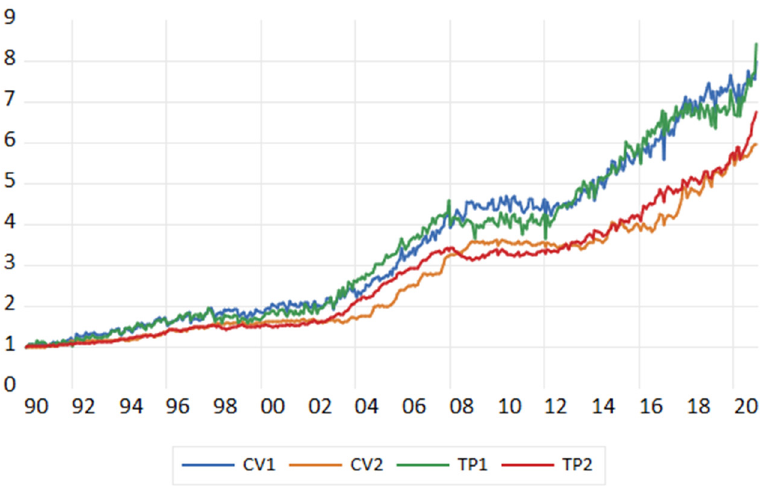
Figure 1. House Price Indices of CV and TP in the primary and secondary house markets of New Zealand, 1990–2020 (Index = 100 in 1990). Notes: The four house price indices of New Zealand from 1990 to 2020 are (TP1) hedonic house prices index in the primary market; (CV2) capital values index in the secondary market; and (TP2) hedonic house price index in the secondary market. For the capital value index of the primary market (CV1), we use the estimated CV typically released by the government after the housing transaction.